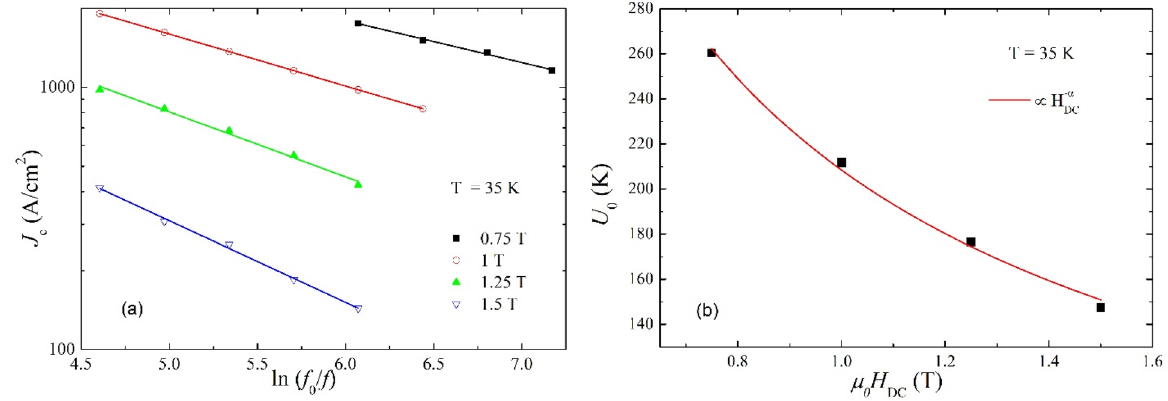
Figure 6. Frequency dependence of the critical current density, calculated from the susceptibility measurements using Brand’s formula, at 35 K, in the DC fields indicated in the figure, in double-logarithmic plot. The slopes b of the linear fits allows to estimate the values of the pinning potential U 0 ( a ); DC field dependence of the pinning potential, in K ( k B = 1). Full line represent a power-law fit U 0 ∝ H − α DC , with α ≈ 0.8 resulting from the fitting procedure ( b